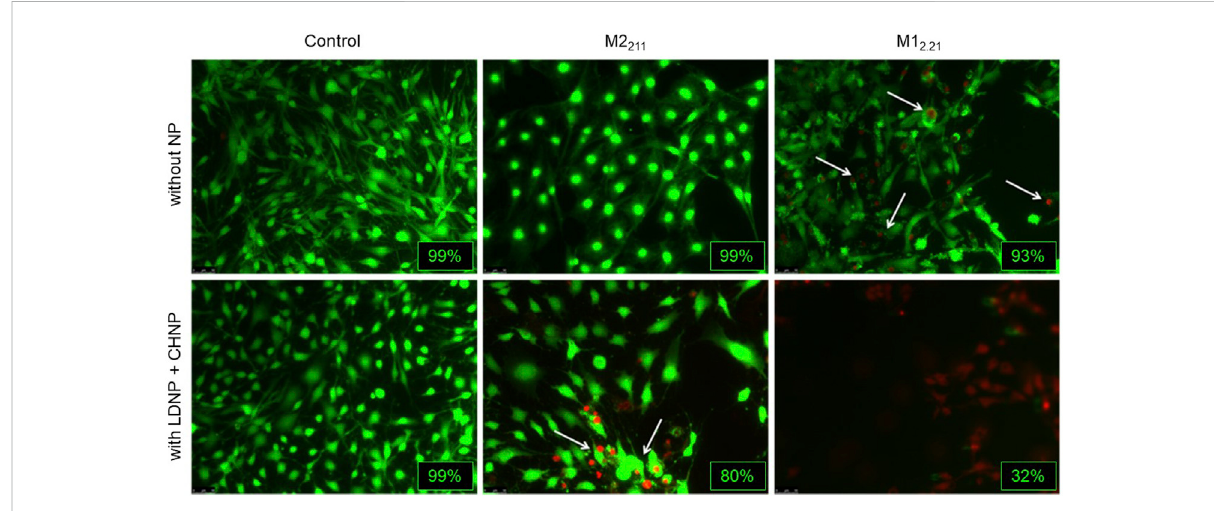
FIGURE 4 Biomembranes biocompatibility. Membranes M1 2.21 and M2 211 toxicity against 3T3 cells, either with or without embedded LDNP and CHNP. Green fl uorescence (calcein staining) indicates viable cells, while red fl uorescence (EthD-1 staining) indicates non-viable cells. Viabilities, calculated via Eqn 4, are shown for each